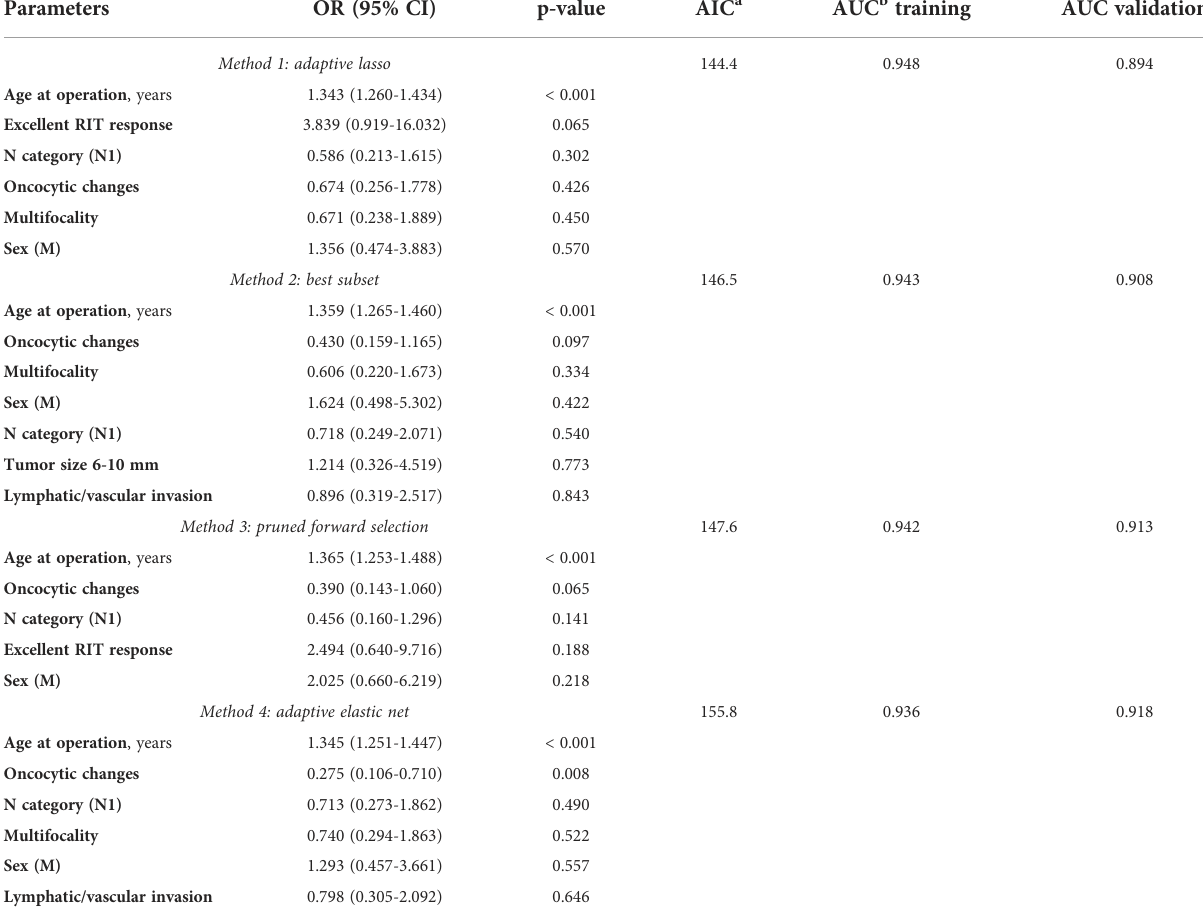
TABLE 6 The variables potentially contributing to the differences between the non-incidental radiogenic and sporadic papillary thyroid microcarcinomas selected by different statistical